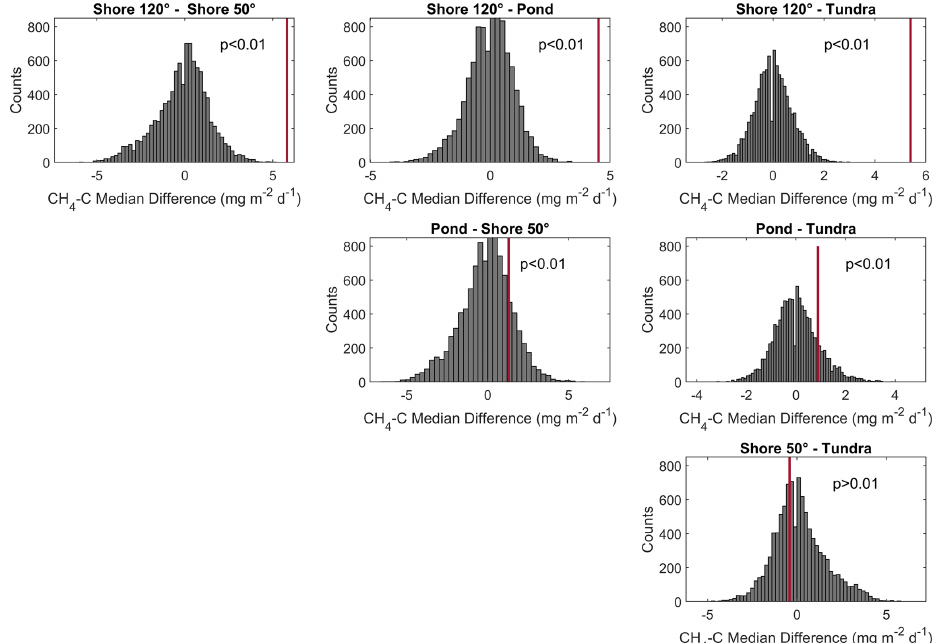
Figure A5. Histogram of permutation tests between the medians of CH 4 emissions from different wind direction classes in Fig. 6. All medians from flux observations during moderate air temperature conditions. The observed differences in medians between the different wind direction classes are shown in red vertical bars in each